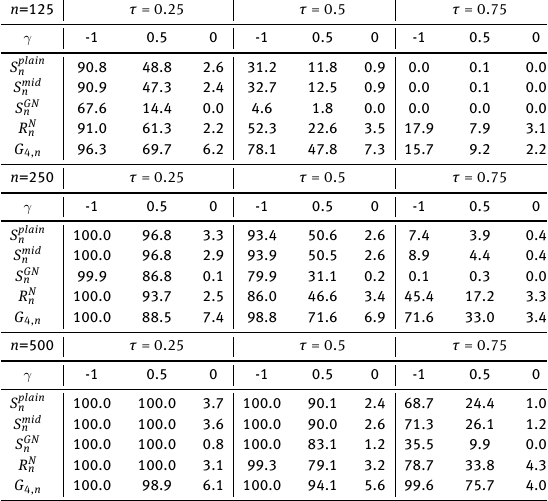
Table 8: Percentages of rejection at a 5% significance level, as estimated from 1000 replicates, for the tests based on S plain n , S mid n , S GN n , R N n and G 4, n under the Skew t-student copula with ν = 4 degrees of freedom, in dimension 10 .